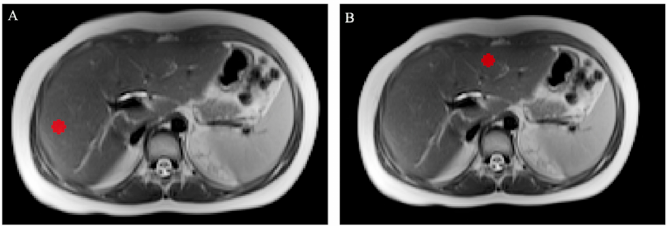
Figure 2. Axial T2-weighted MRI scans showing the right ( A ) and left ( B ) lobe ROIs drawn for texture analysis; care was taken to exclude the great vessels and motion artefacts.